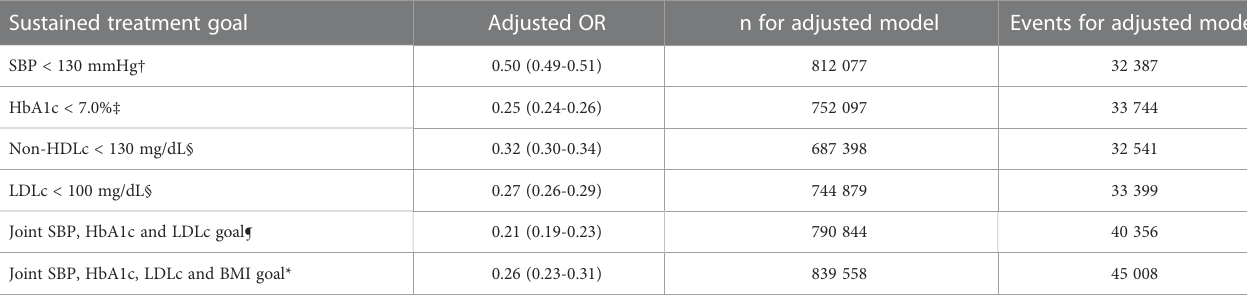
TABLE 4 Association between metabolic control and mortality, excluding patients in CKD stages 4 or 5 at baseline. Sustained treatment